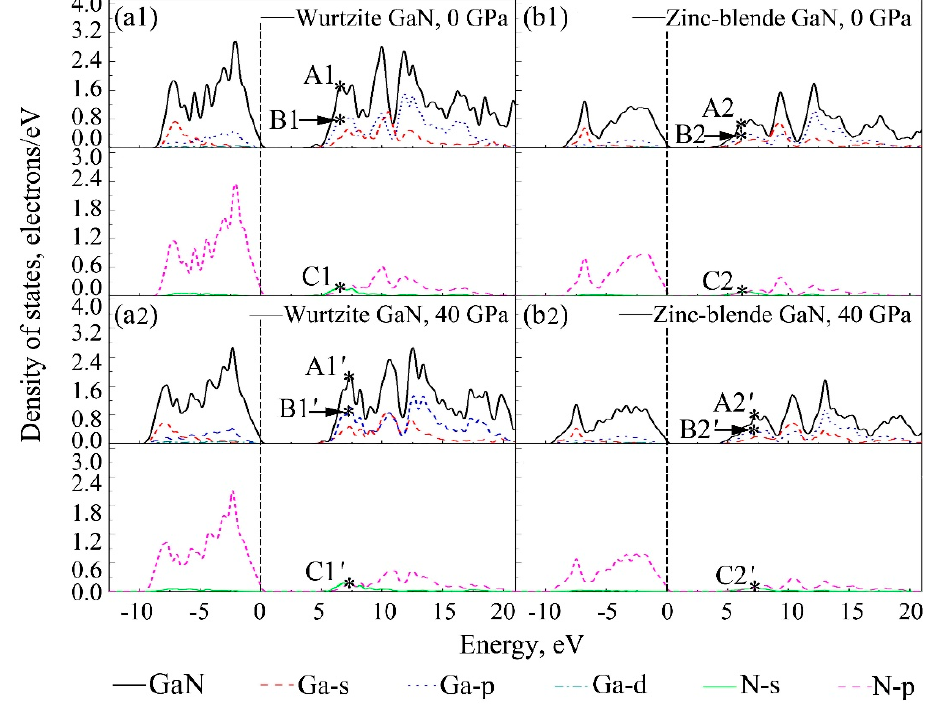
Figure 10. Pressures versus density of states (DOSs) for: ( a1 ) wurtzite GaN, 0 GPa; ( a2 ) wurtzite GaN, 40 GPa; ( b1 ) zinc-blende GaN, 0 GPa, ( b2 ) zinc-blende GaN, 40 GPa. 40 GPa; ( b1 ) zinc-blende GaN, 0 GPa, ( b2 ) zinc-blende GaN, 40